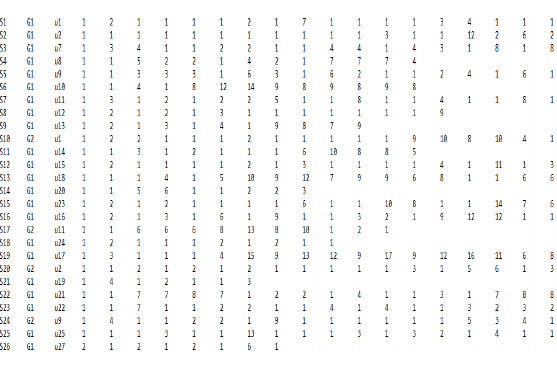
Figure 12. Sequence File